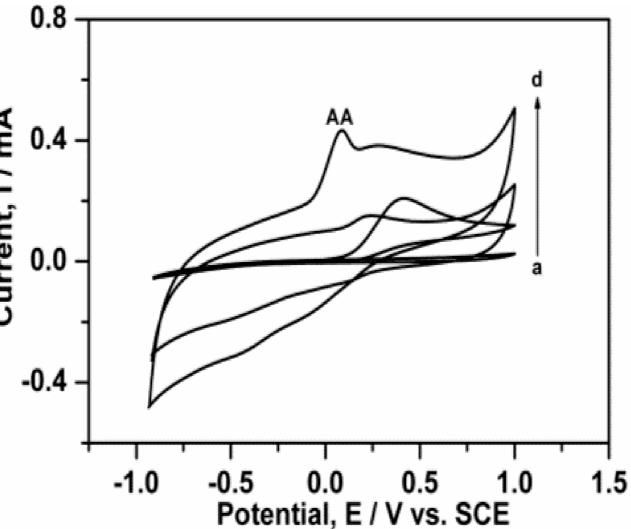
Figure 12. Cyclic voltammograms of (a) Bare graphite (b) Bare graphite with 5 mM ascorbic acid (AA) (c) NiO/G electrode in 0.1 M phosphate-buffered saline (PBS), pH 7.0 (d) NiO/G with 5 mM AA in 0.1 M buffer solution. Taken from Swamy et al.